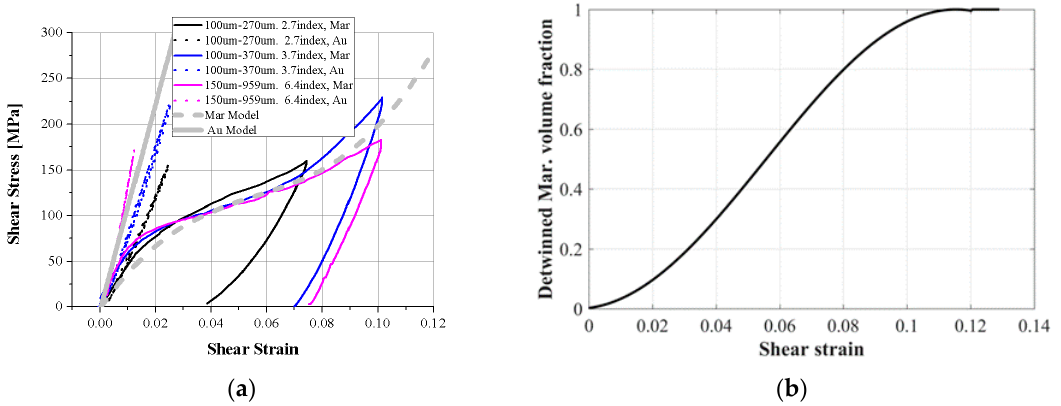
Figure 3. ( a ) The strain–stress relationship converted from displacement–force results of three kinds of SMA coil spring; ( b ) the detwinned martensite volume fraction of the martensite model.